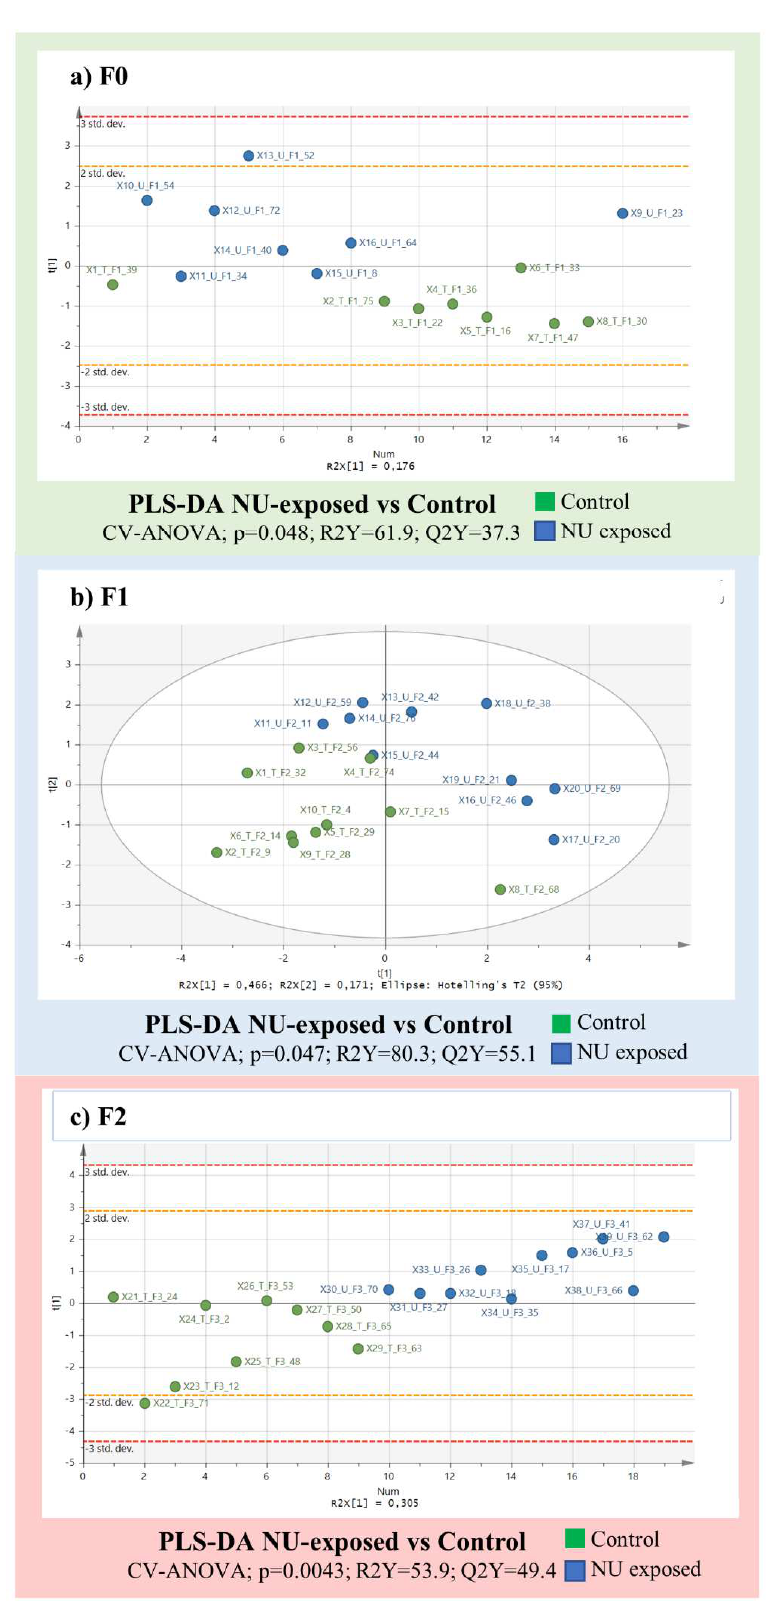
Figure 4. PLS-DA model calculated using spermatozoa samples collected from each generation (control in green and NU-exposed in blue). For generations F0 ( a ) and F2 ( c ), only one component was used, however, for generation F1 ( b ), two components were used for